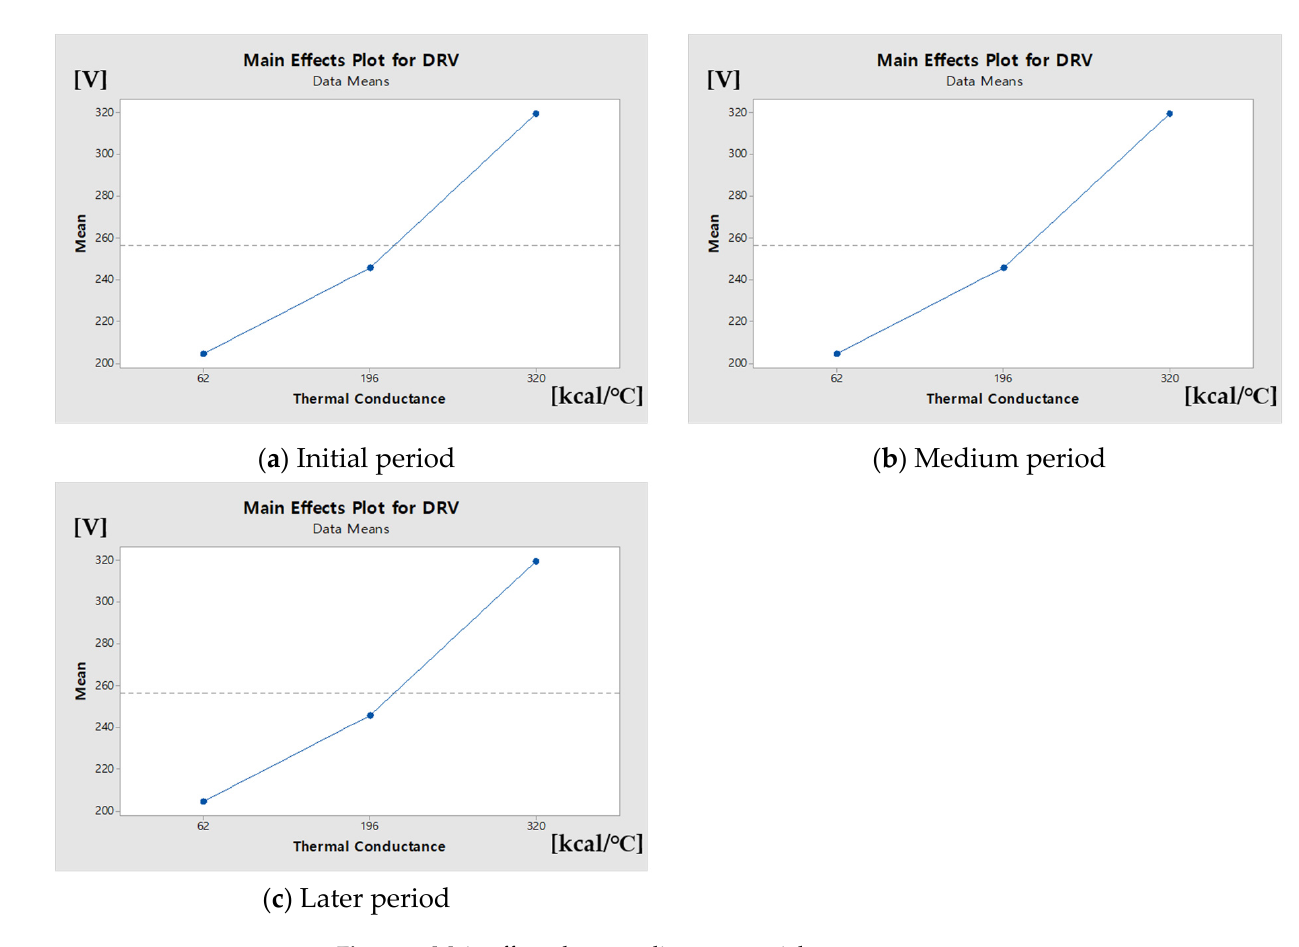
Figure 1. Main effect plot according to material.